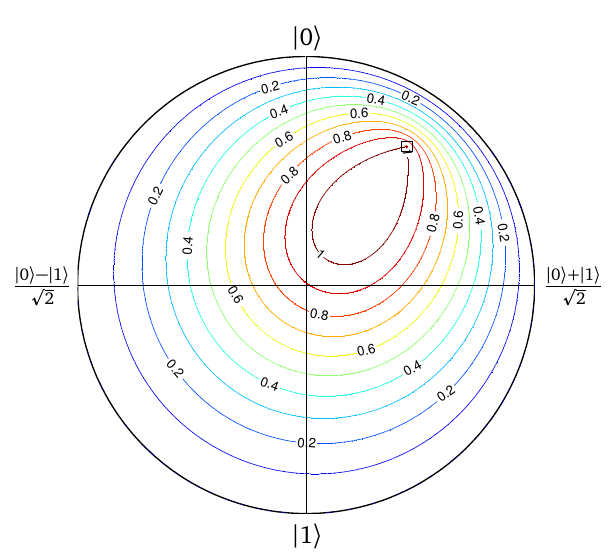
Entailment strengths in the Bloch disc for the state with Bloch vector